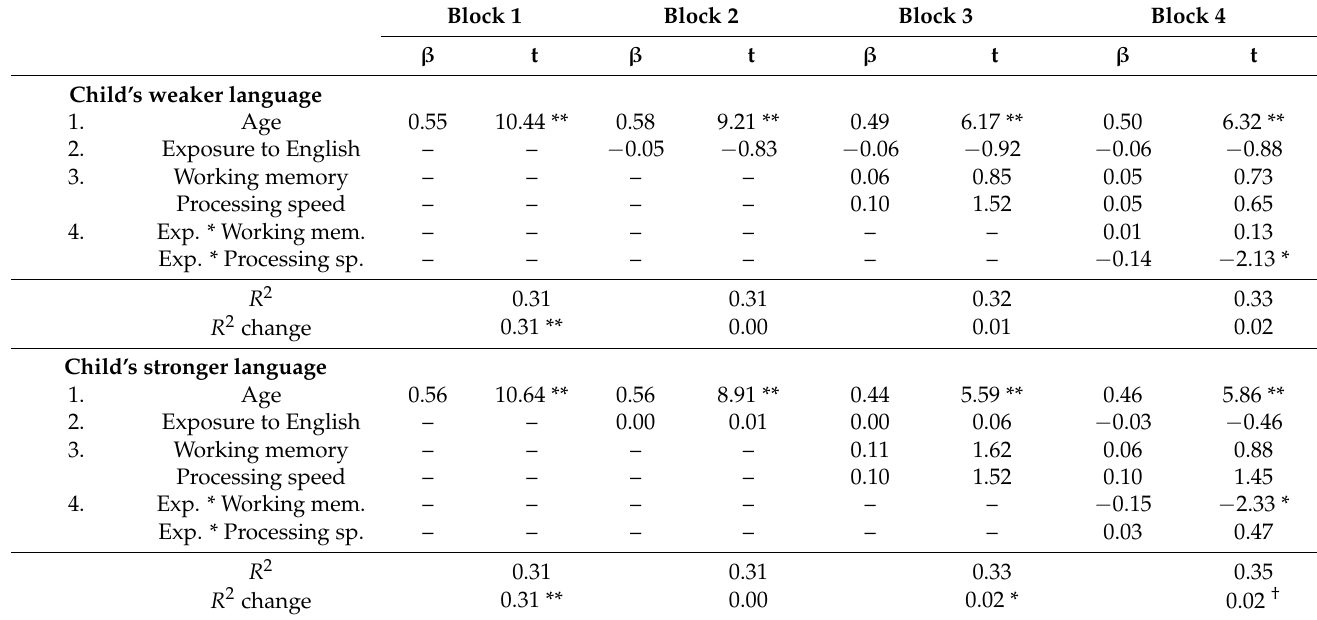
Table 8. Model summaries of regressions predicting morphosyntax performance using narrative tasks in children’s weaker and stronger